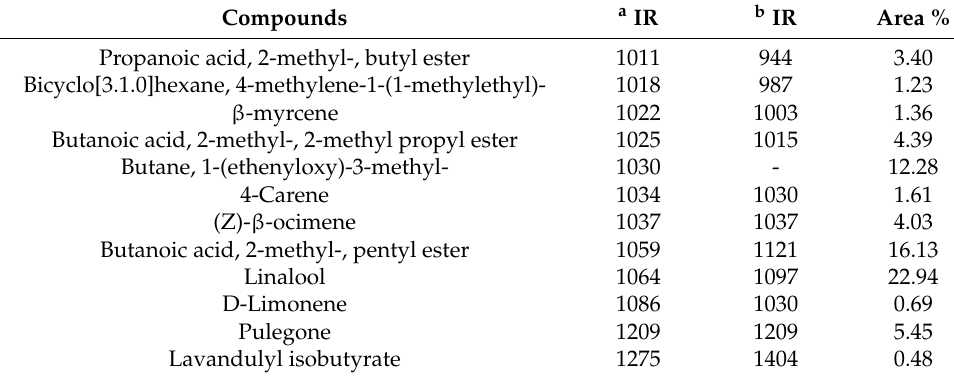
Table 1. Chemical composition of A. visnaga L. essential oil. Compounds a IR b IR Area % Propanoic acid, 2-methyl-, butyl ester 1011 944